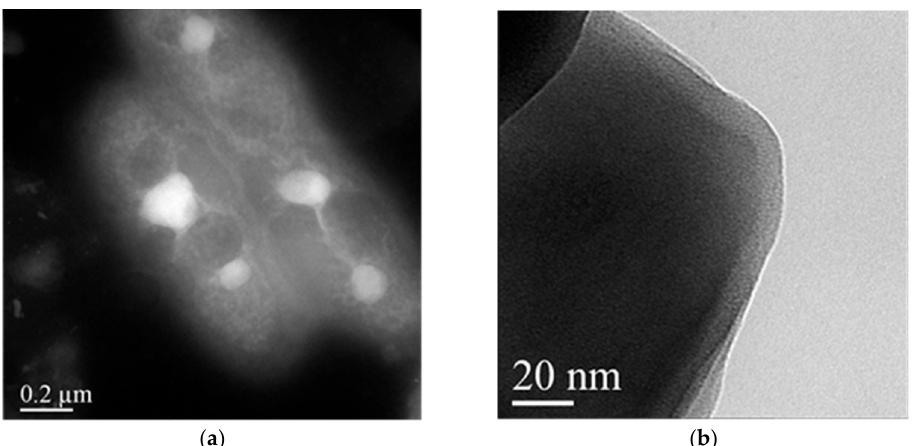
Figure 3. STEM images of non-overloaded CS NPs at different magnifications. Images are representative of at least three independent experiments. The bar width in the panels ( a ) 200 nm and ( b ) 20 nm indicated the size.